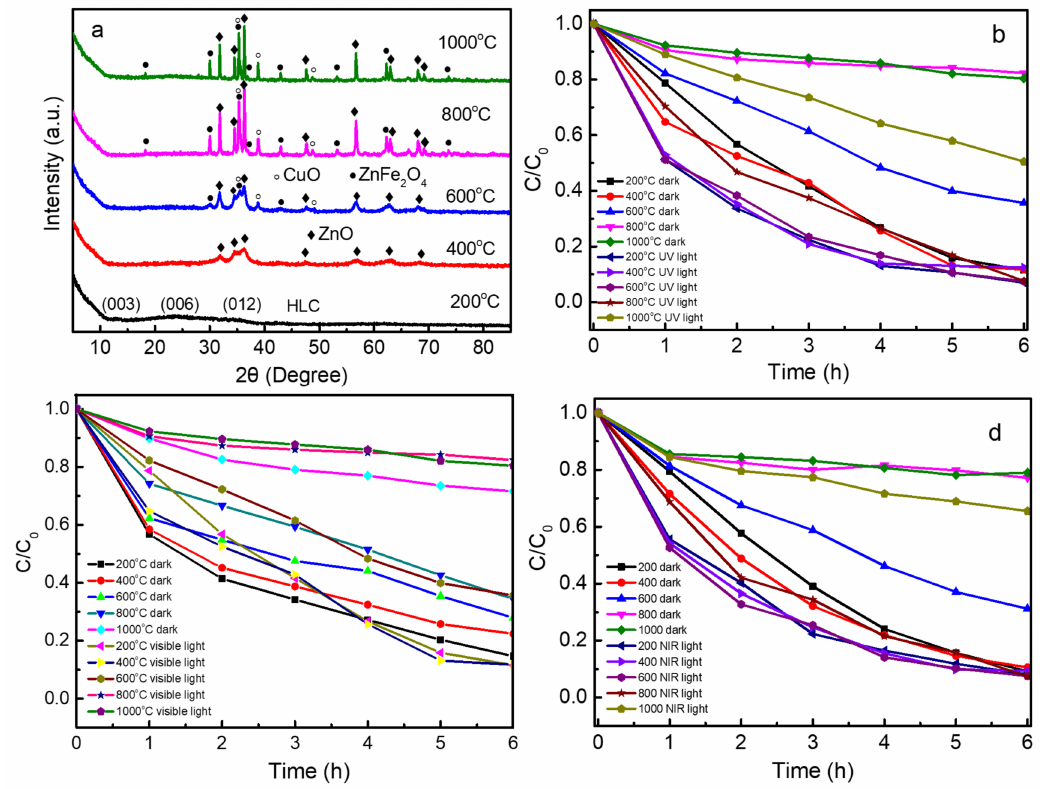
Figure 1. ( a ) X-ray diffraction (XRD) patterns for the ZnO/CuO/ZnFe 2 O 4 nanocomposite derived from calcination for 3 h at different temperatures; photocatalytic activity for various ZnO/CuO/ZnFe 2 O 4 nanocomposites in the presence of 1.0 mL of 10 wt. % H 2 O 2 under ( b ) UV, ( c ) visible and ( d ) NIR